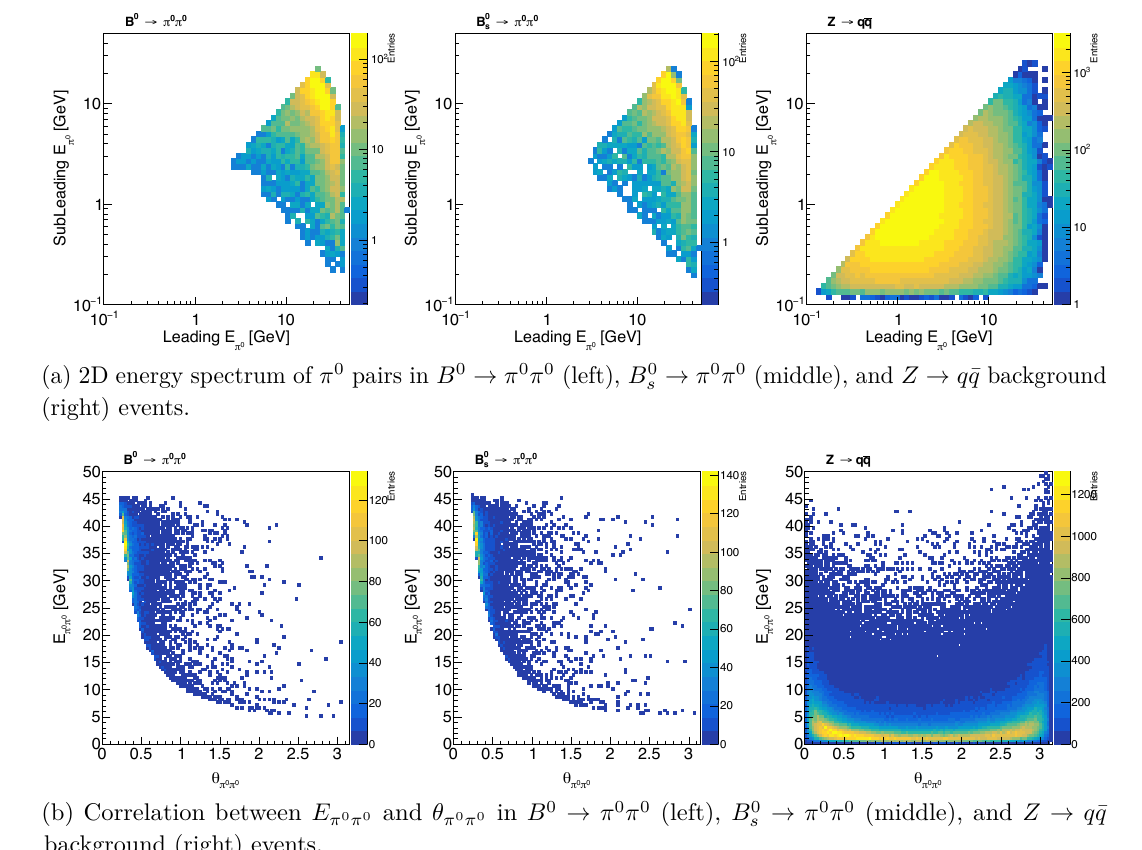
→ π 0 π 0 (middle), and Z → q ¯ q s → π 0 π 0 , and s